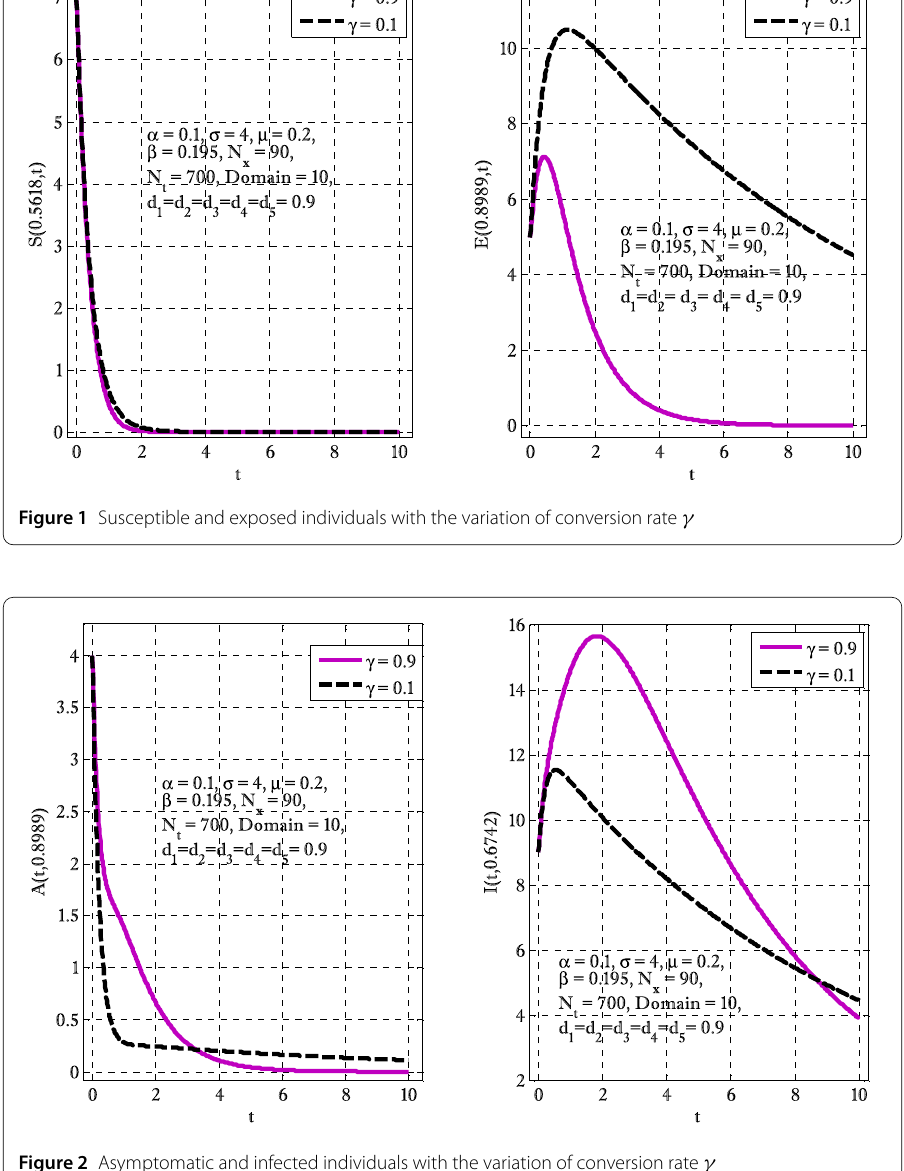
Figure 2 Asymptomatic and infected individuals with the variation of conversion rate γ